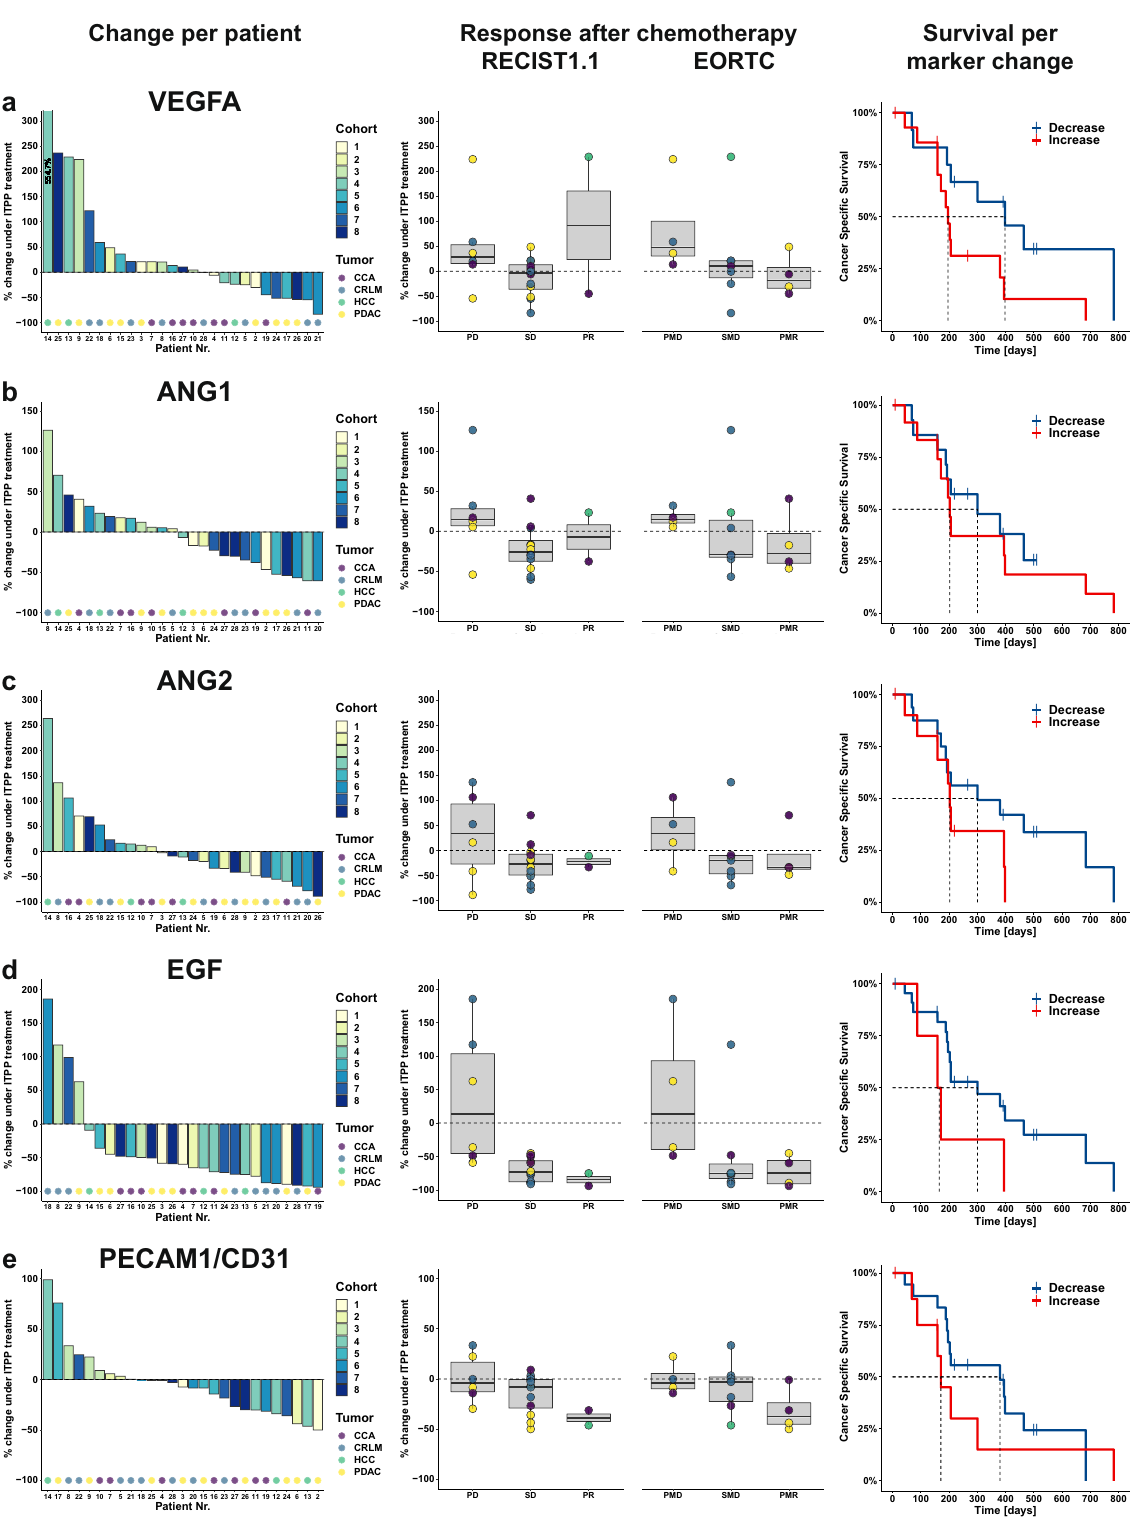
Fig. 3 Changes in serum angiogenic markers post ITPP and correlation with chemotherapy responses and survival. Changes in circulating levels of VEGFA ( a ), ANG1 ( b ), ANG2 ( c ), EGF ( d ), and PECAM1/CD31 ( e ). Percental changes of pre- versus post-ITPP monotherapy markers levels are depicted (from left to right) by patient as waterfall plots. Association of morphological and metabolic response post chemotherapy with changes in serum angiogenesis markers under ITPP treatment are shown as boxplots displaying median values with the upper and lower ends representing the 25 th and 75 th quartiles, respectively. Whiskers extend to values within 1.5 * IQR from the boxplot, with all individual data points shown overlaid and colored according to tumor type. Survival strati fi ed by decreased or increased marker levels displayed as Kaplan – Meier curves. n = 27 individual patients, marker measurements performed as technical